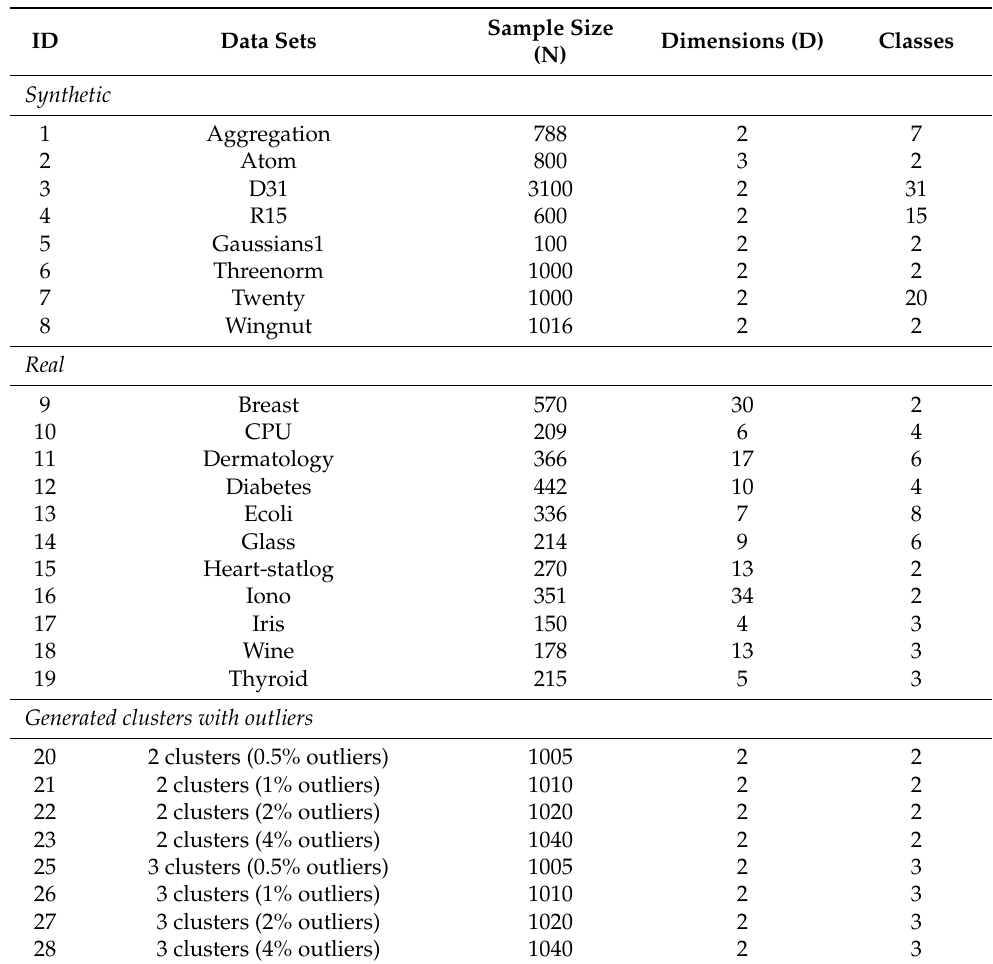
Table 1. A description of the data set